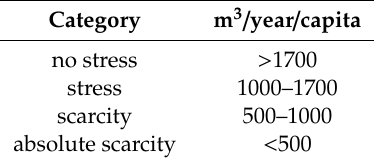
Table 2. Falkenmark categories.